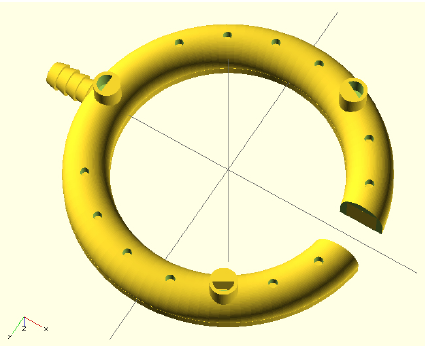
Figure 20. A rendering in OpenSCAD of a customizable 3-D printable hydroponic halo ring.